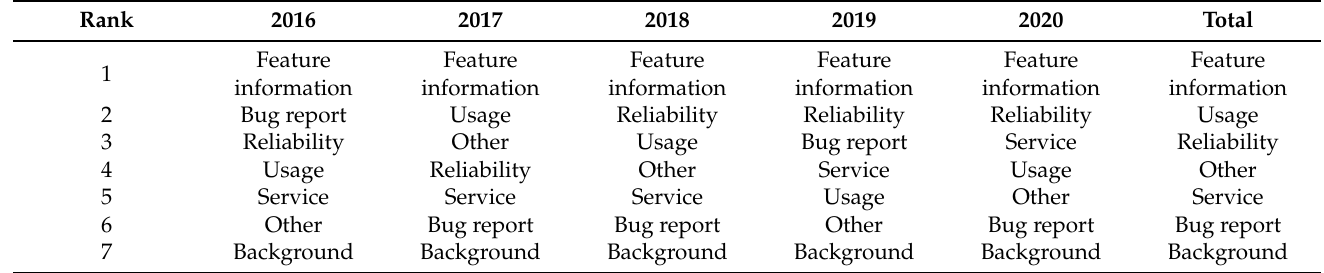
Table 3. Ranking Table of dimension weight of the Ping An Health App from 2016 to 2020.